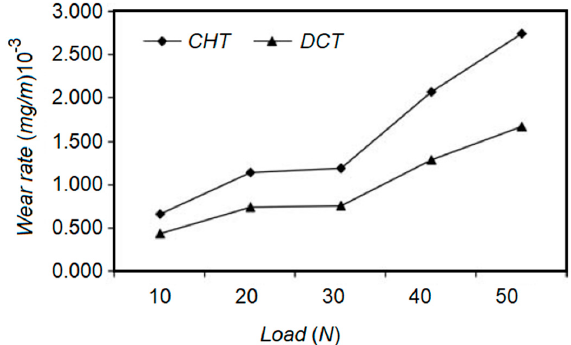
Figure 9. Wear rate of 100Cr6 bearing steel at 5 Hz frequency for the conventional heat treatment (CHT) and DCT [73].